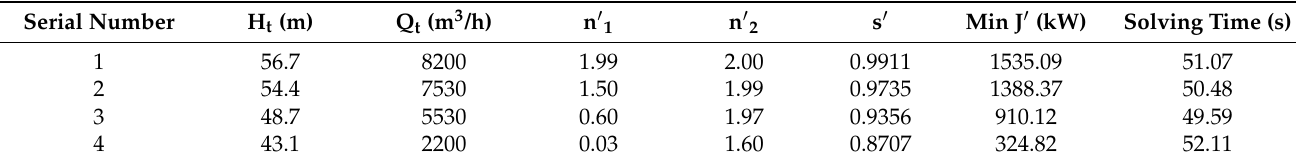
Table 2. Part of the results from the GA optimization process.